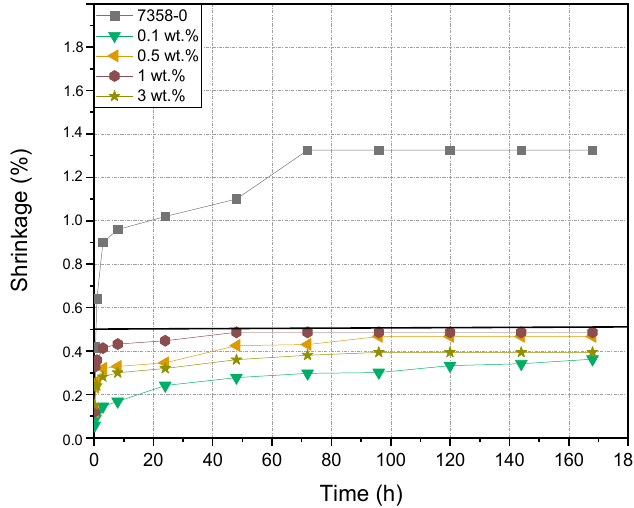
Figure 15. Influence of palygorskite-1.0MPTMS addition on shrinkage Si-PSA.